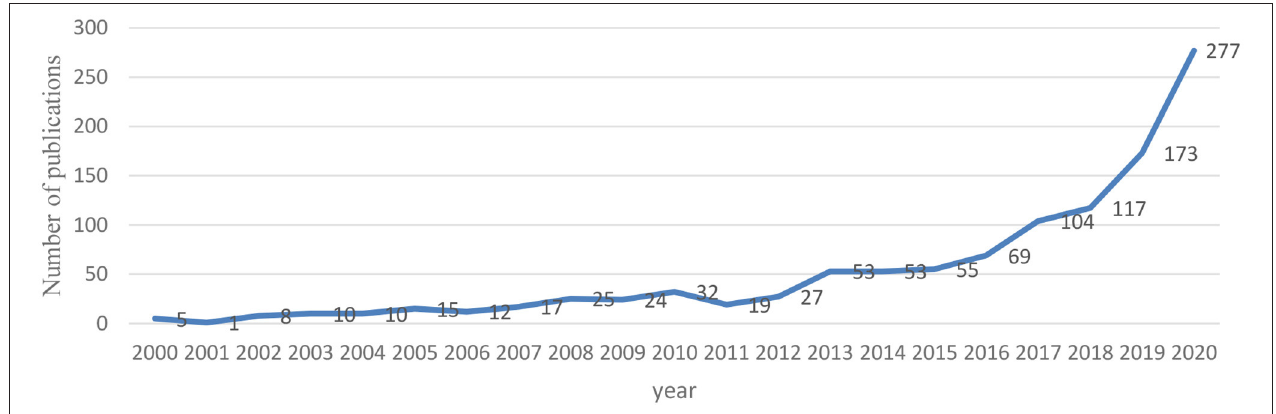
FIGURE 2 | Trends in publications in the field of intermittent fasting from 2000 to